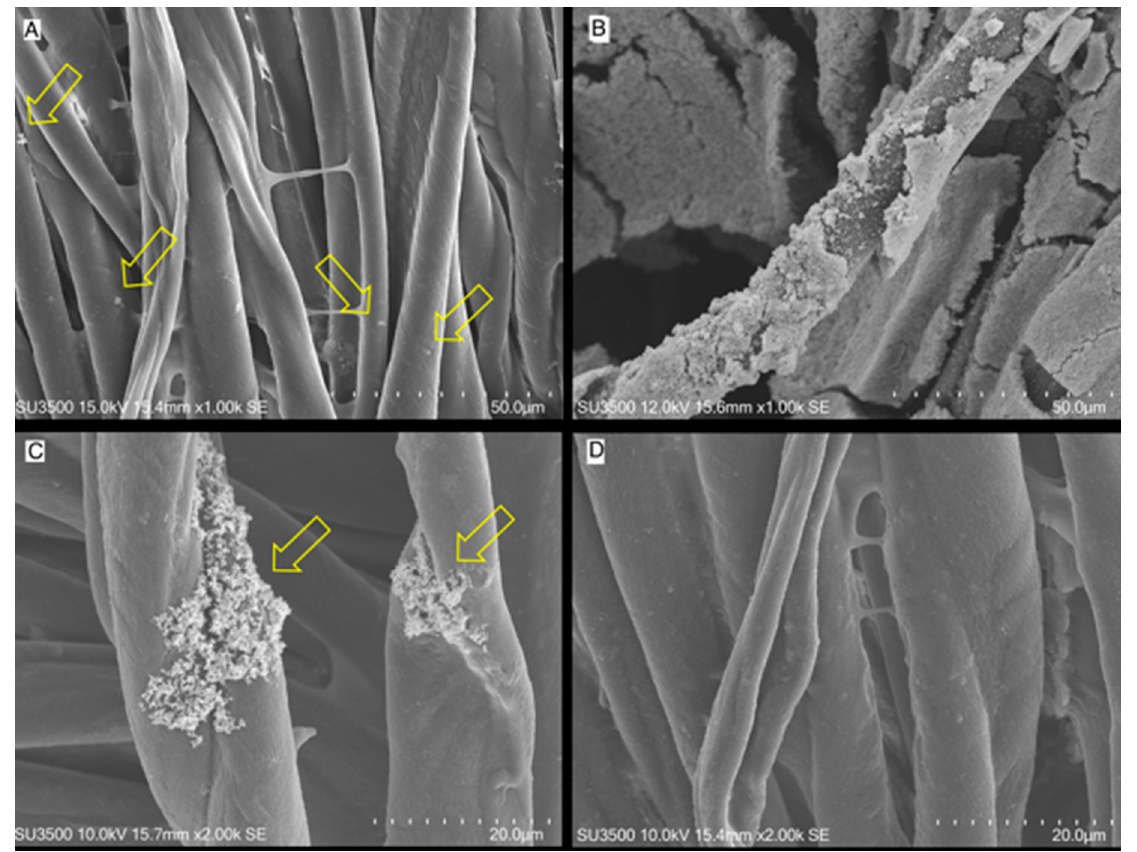
Figure 5. SEM microscopy of GO coated textiles. ( A , B ) Upper filter surface, ( C , D ) lower filter surface ( A , C ) SEM image of 5% GO coated fibers, arrows point at scattered viral particles aggregates on the upper and lower surfaces of the filters. ( B , D ) SEM image of 10% GO coated fibers, arrows point at viral aggregates bound on the upper and lower surfaces of the fibers.